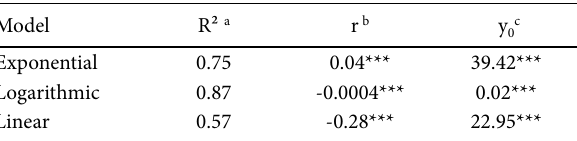
Table 2. Parameters of the linear and non-linear models for the fre- quency of severity of fig rust, in severity